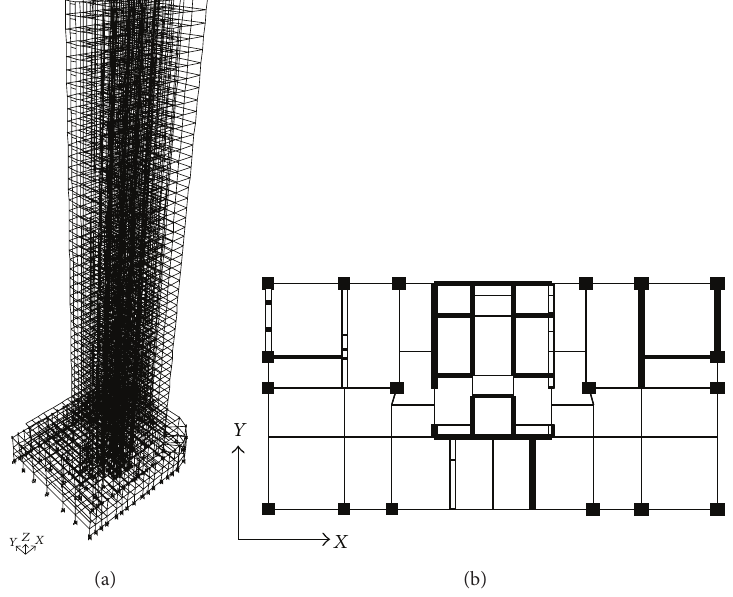
Figure 2: Structural diagram: (a) structural three-dimensional diagram; (b) structural top floor plan diagram.